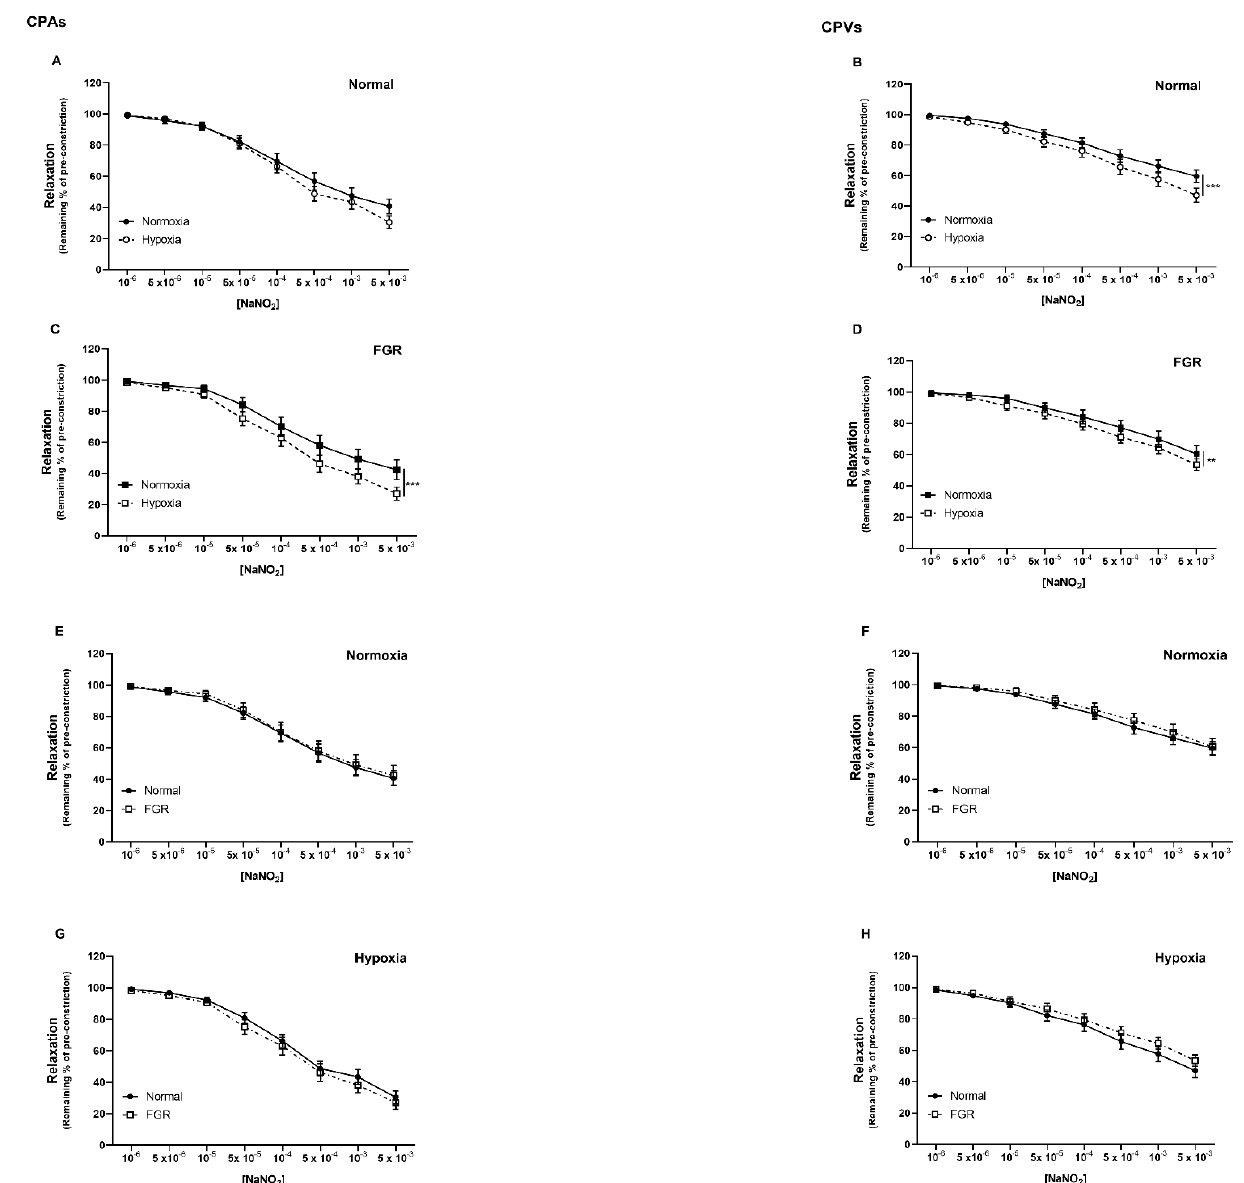
Figure 1. Nitrite − mediated relaxation of human chorionic plate vessels is enhanced by hypoxia in both normal and FGR pregnancies. Concentration − dependent vasorelaxant effect of NaNO 2 on: normal CPAs ( A ) and CPVs ( B ), FGR CPAs ( C ) and CPVs ( D ), in normoxia and hypoxia; normoxic CPAs ( E ) and CPVs ( F ), hypoxic CPAs ( G ) and CPVs ( H ), from normal and FGR pregnancies. ** p < 0.01, *** p < 0.001, normoxia vs. hypoxia. n = 15–32 placentas per